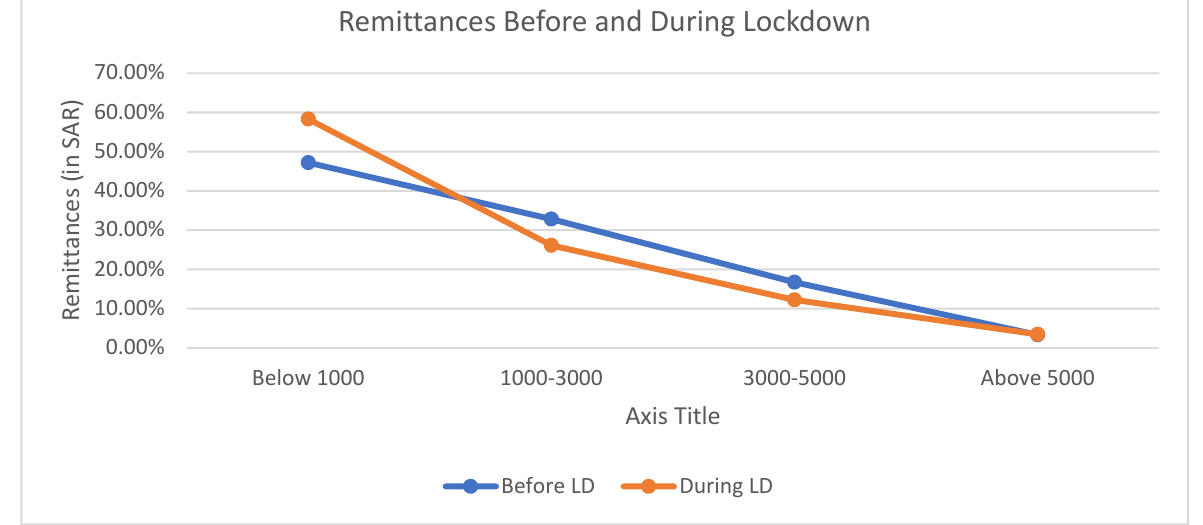
Figure 2. Change in remittances during the pandemic.